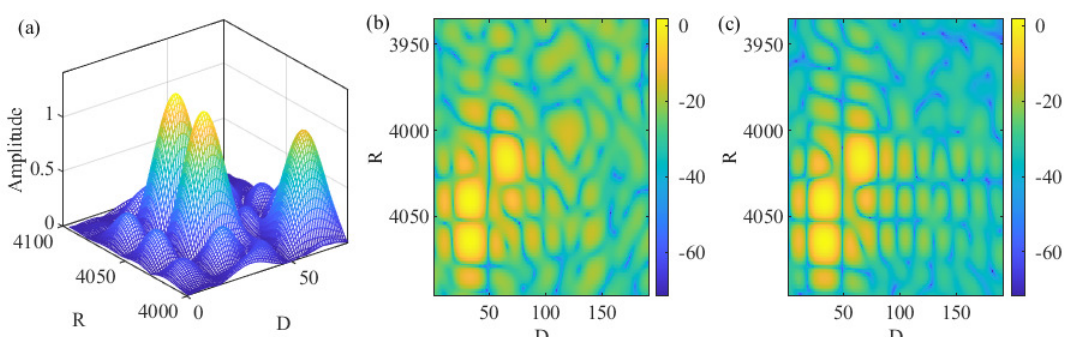
Figure 4. Illustrating RDMs, where “-” in the color bar is the negative sign.Note that | Y m ( b ) | with constant modulus s m ( n ) is plotted in ( a ), demonstrating OFDM under PSK constellations processed by either PWD or PWP. Moreover, | Y m ( b ) | (obtained under PWD) with noise-like s m ( n ) is plotted in ( b ). In addition, | Z m ( b ) | (using PWP) with noise-like s m ( n ) is plotted in ( c ). According to Remark 1, DFT-s-OFDM and OTFS have their frequency-domain signals, i.e., s m ( n ) , conform